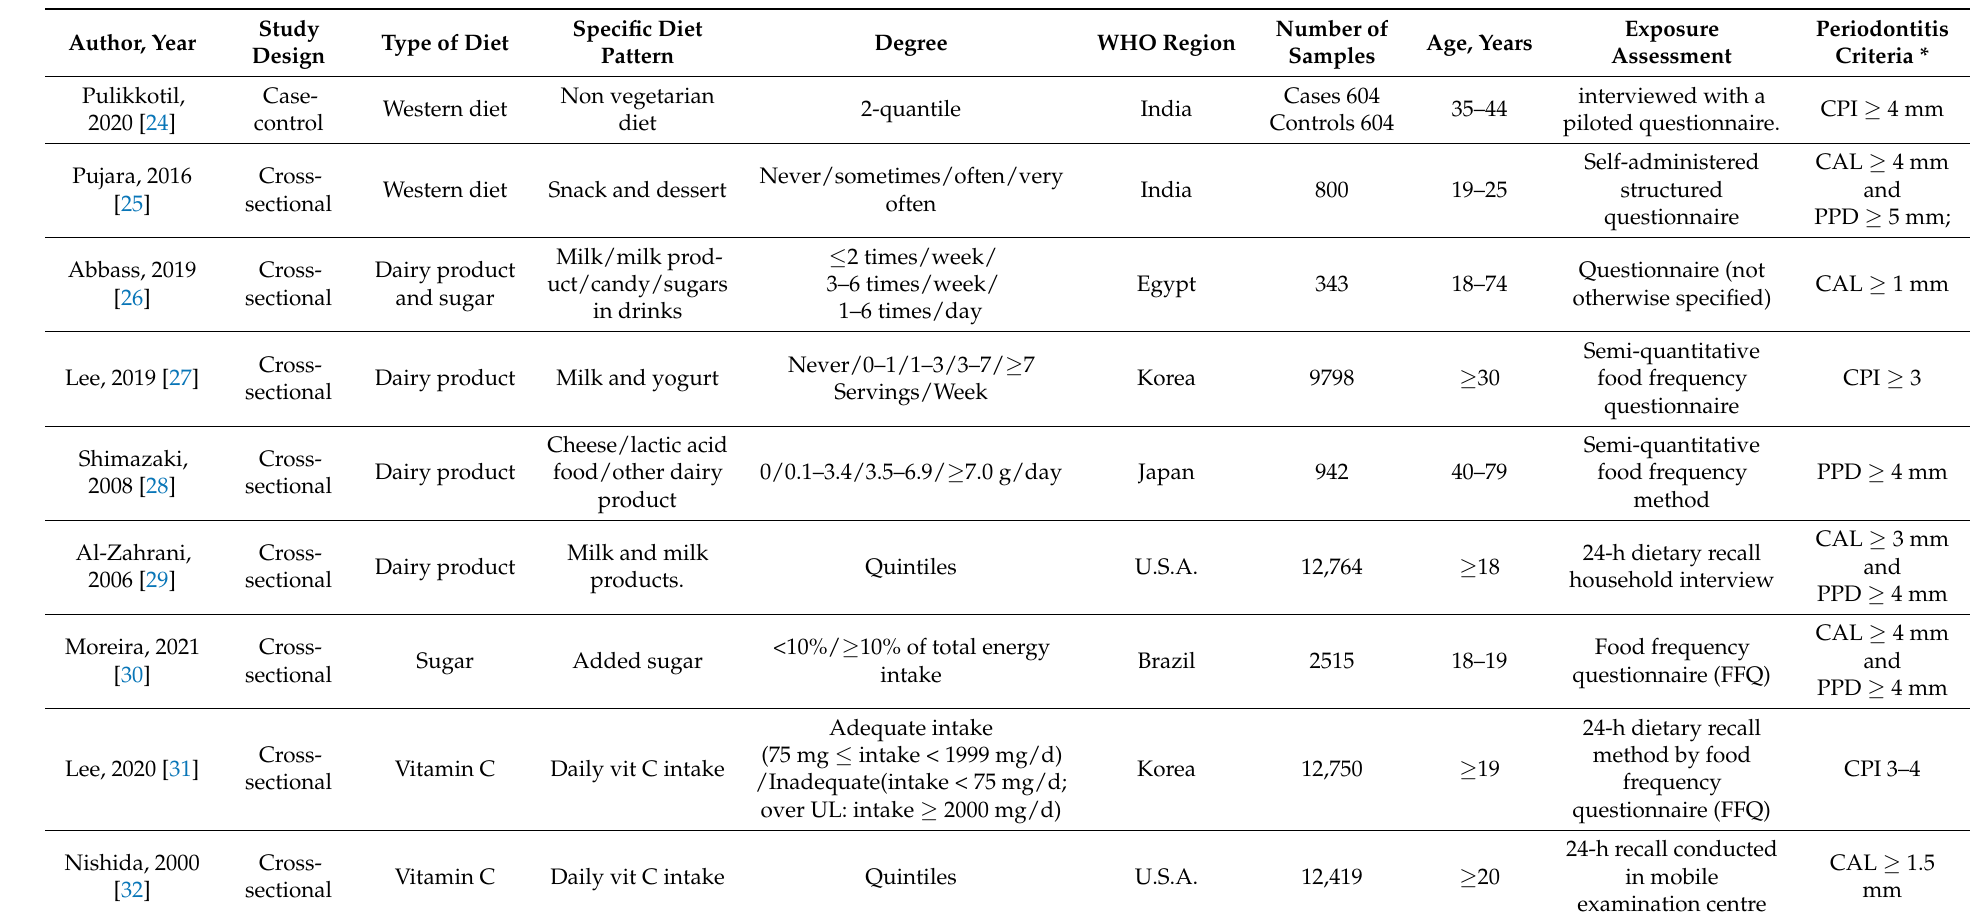
Table 1. Characteristics of the included